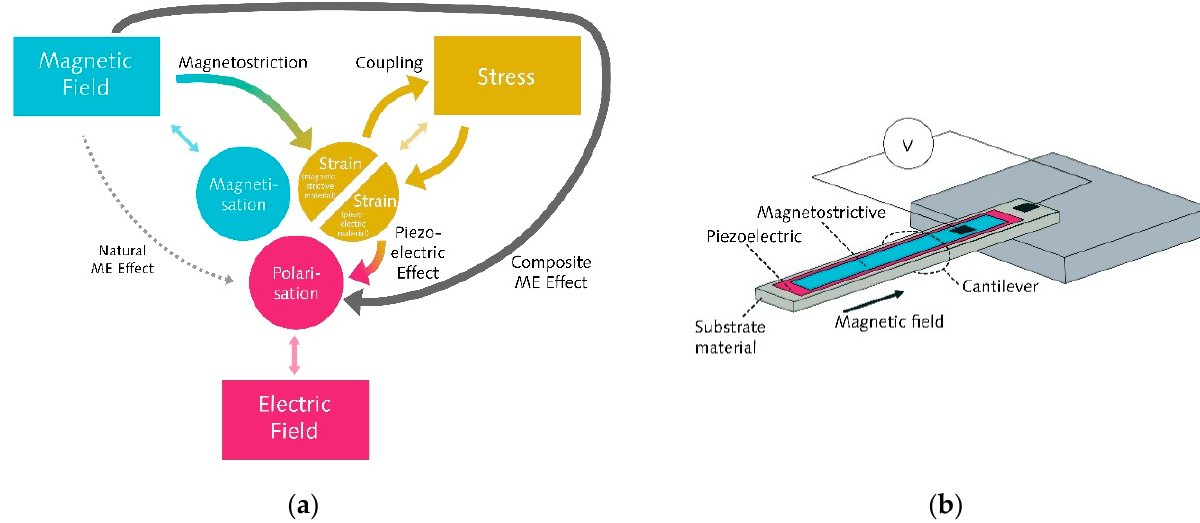
Figure 1. ( a ) Schematic representation of the composite ME effect and the natural ME effect. In this representation, only the direction that is used for magnetoelectric sensing is illustrated; ( b ) illustration of a ME cantilever beam sensor.